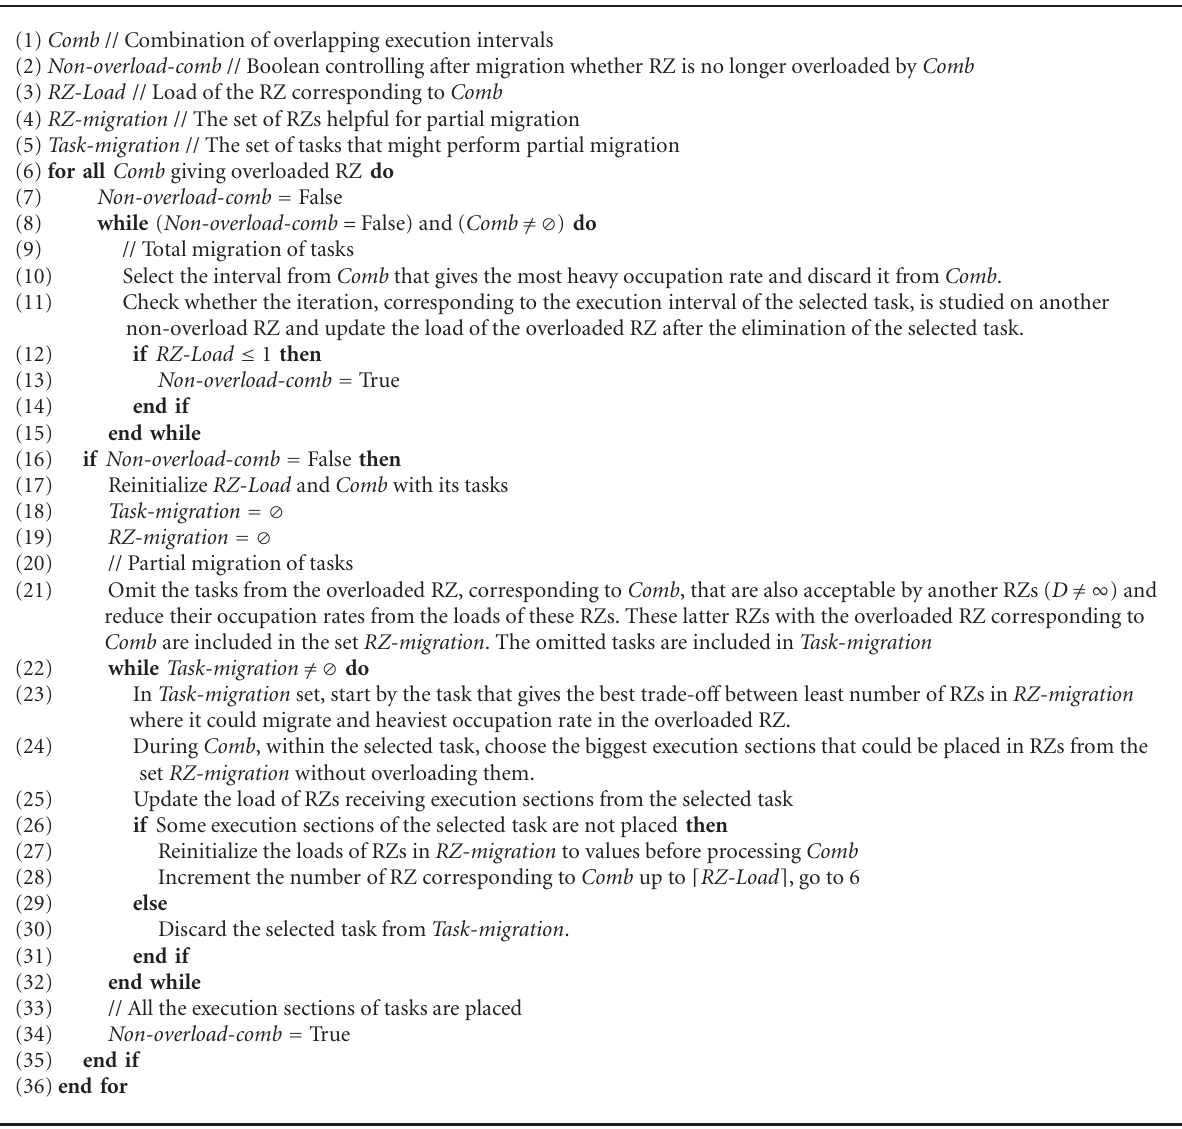
Algorithm 4: Total and partial migration or addition of RZs.